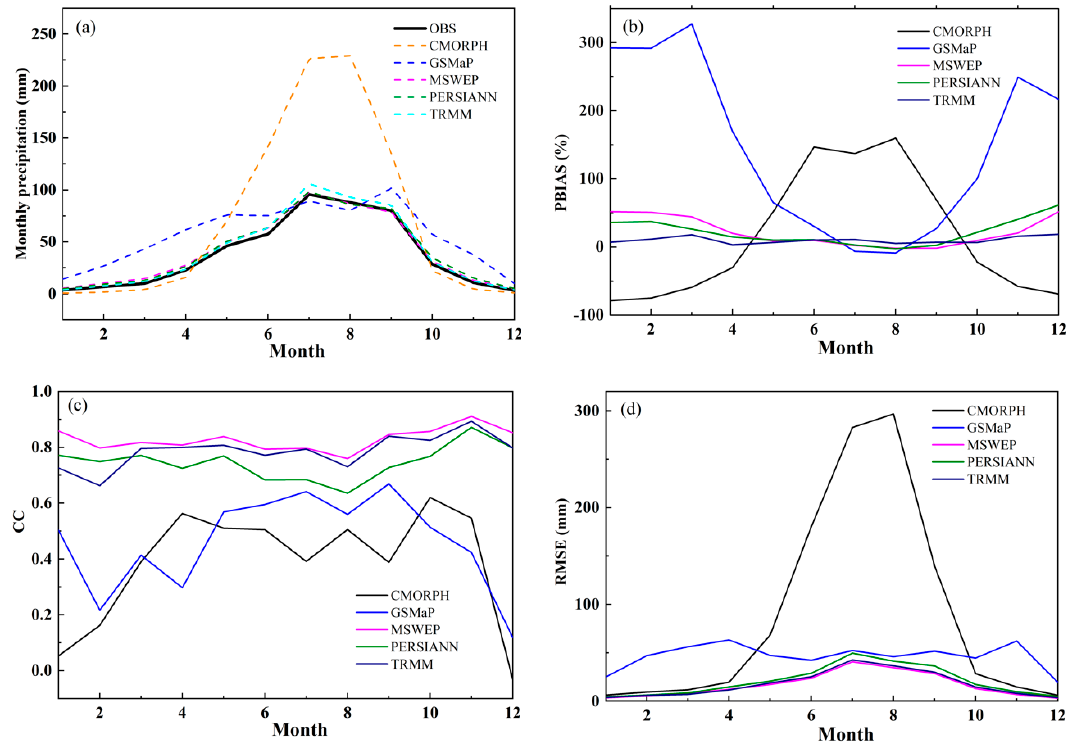
Figure 5. ( a ) variation of monthly precipitation, ( b ) PBIAS, ( c ) correlation coefficient and ( d ) root mean square error during the year. PBIAS is bias, CC is correlation coefficient, RMSE is root mean square error.